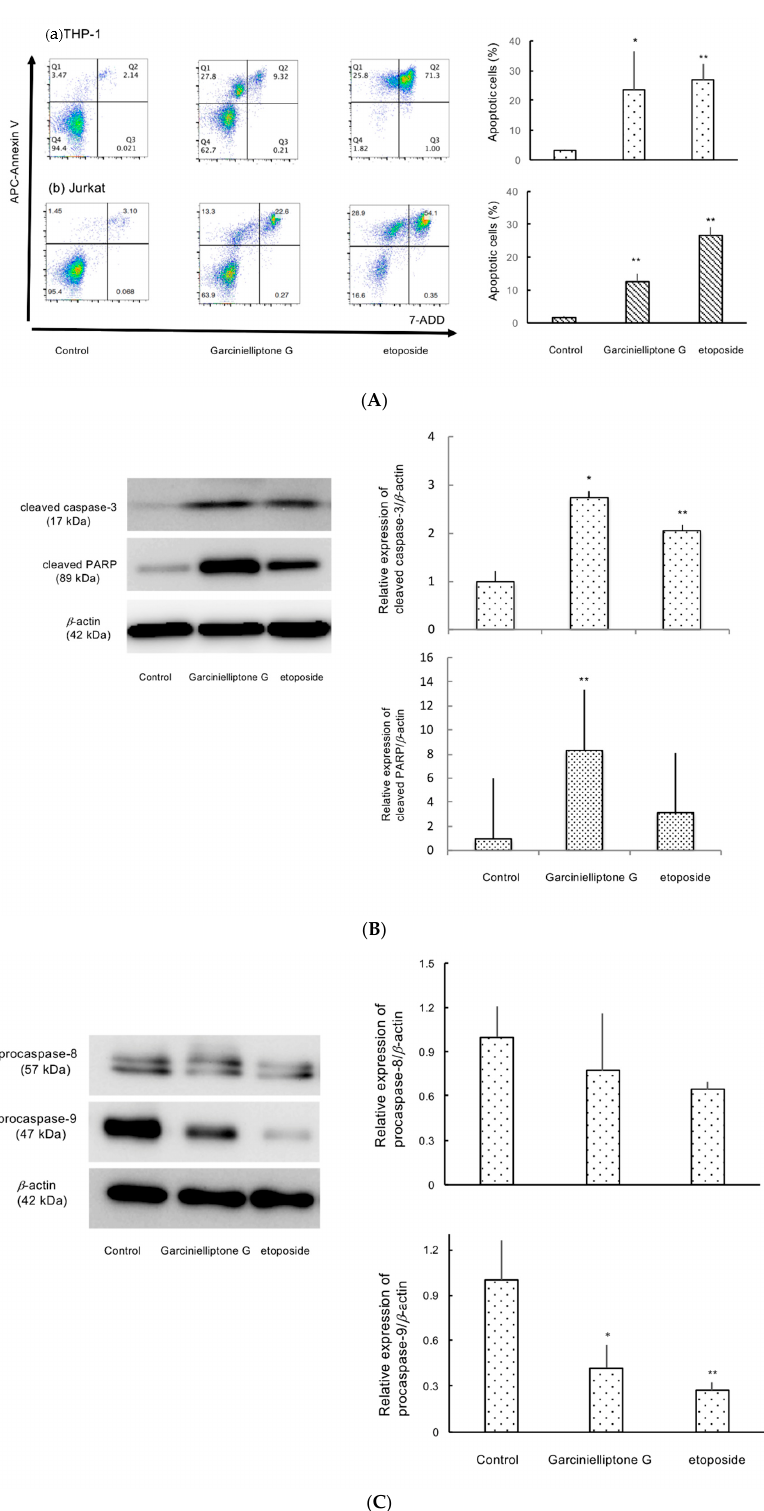
Figure 3. Garcinielliptone G ( 5 ) induces apoptosis. ( A ) Cells were treated with 10 µ M garcinielliptone G ( 5 ) for 24 h, stained with APC Annexin/7-ADD, and analyzed by flow cytometry. Etoposide (1 µ M) was used as a positive control. ( B ) and ( C ) THP-1 cells were treated with 10 µ M garcinielliptone G ( 5 ) for 24 h, and cell lysates were prepared. Cleaved caspase 3, cleaved PARP, procaspase 8, and procaspase 9 protein levels were determined by western blot analysis. β -actin expression was determined to confirm equal protein loading. Values are presented as the mean ± SD of three independent experiments. * p < 0.05, ** p < 0.01.